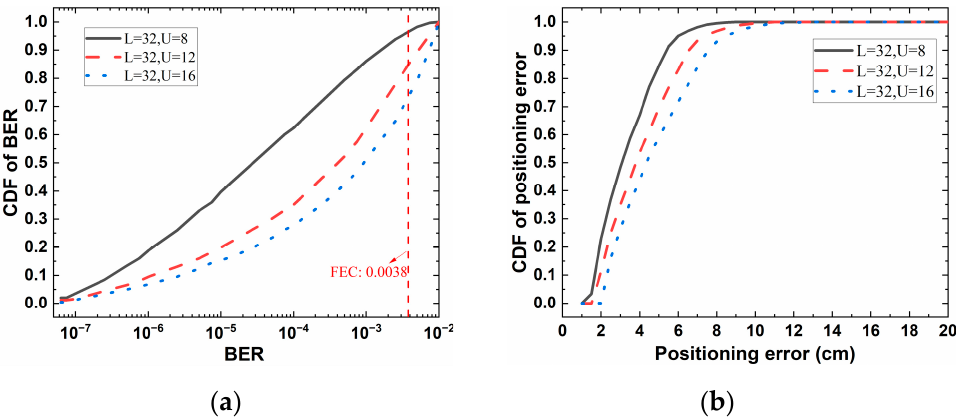
Figure 6. CDF of ( a ) BER and ( b ) positioning error estimated in the whole receiving plane when the multi-user VLCP system supports different numbers of users.